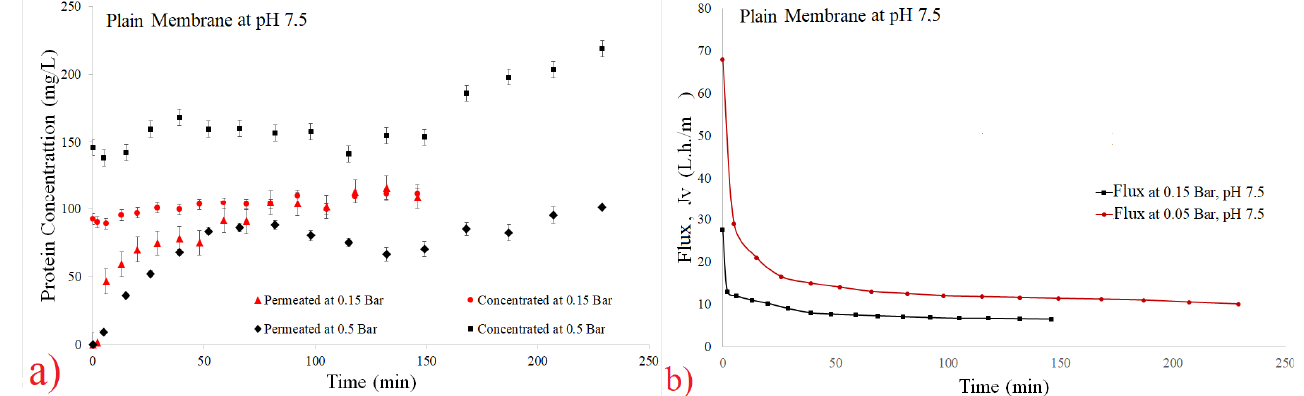
Figure 4. Effect of pressure on filtration flux of the 0.1 µm plain membrane at pH 7.5. ( a ) Total protein curves and ( b ) flux curves.